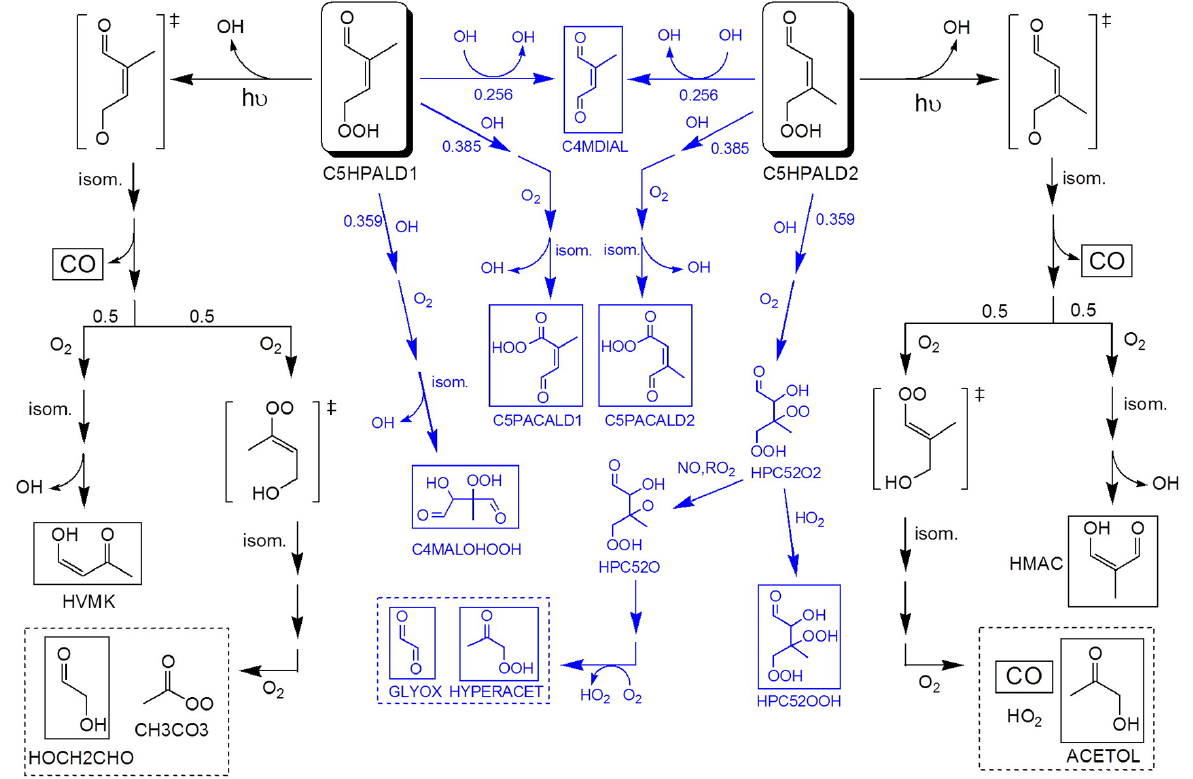
Figure 9. Overview of the degradation mechanisms for the unsaturated C 5 hydroperoxyaldehydes, C5HPALD1 and C5HPALD2, as currently represented in MCM v3.3.1. The (major) chemistry initiated by photolysis is shown in black, and the (minor) OH-initiated chemistry is shown in blue. For clarity, the reactions of the peroxy radicals with NO 3 are not